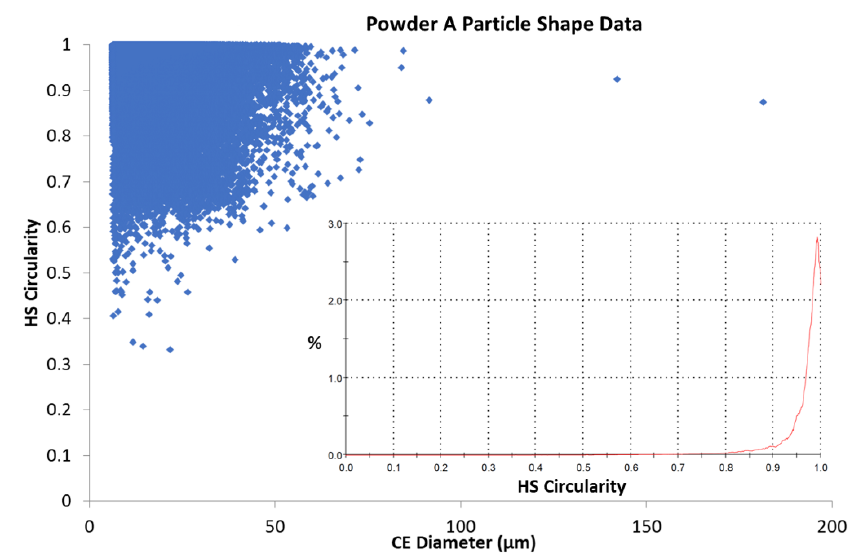
Figure 7. Relationship between particle circularity and Circular Equivalent (CE) Diameter for powder A. (Inset): Number based distribution for HS Circularity.